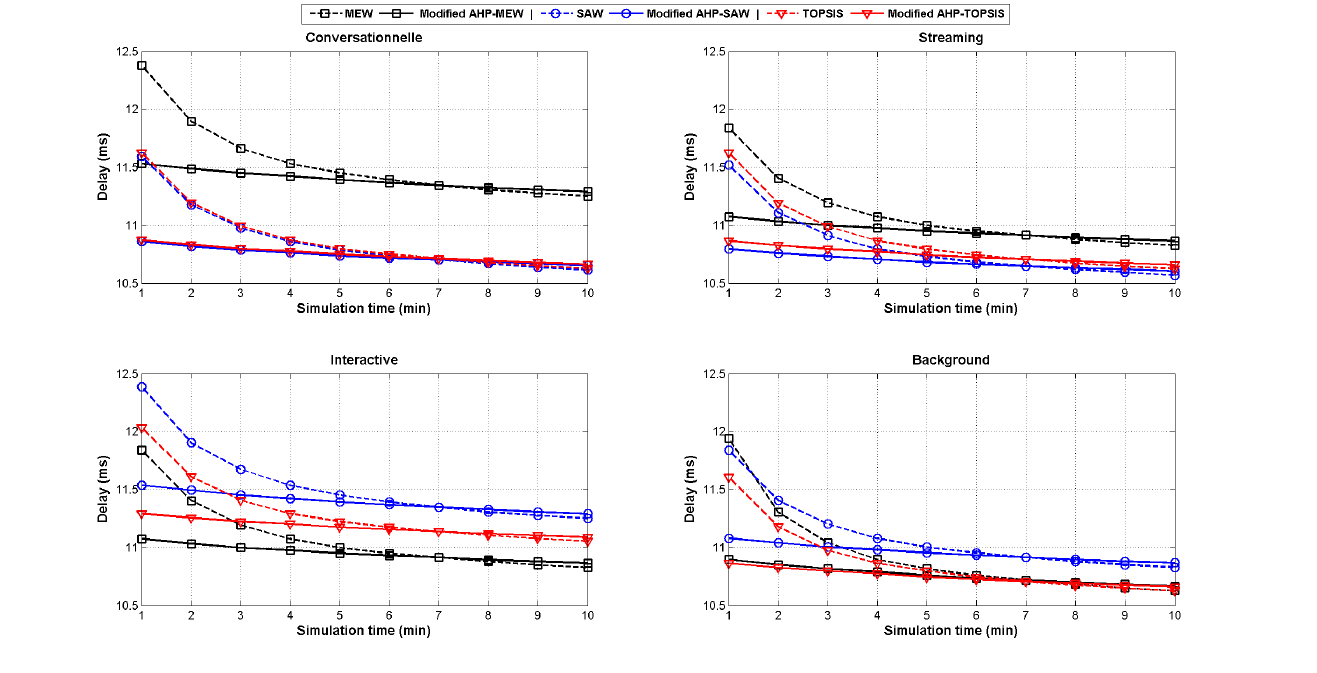
Figure 3. Behavior of Delay over Time.